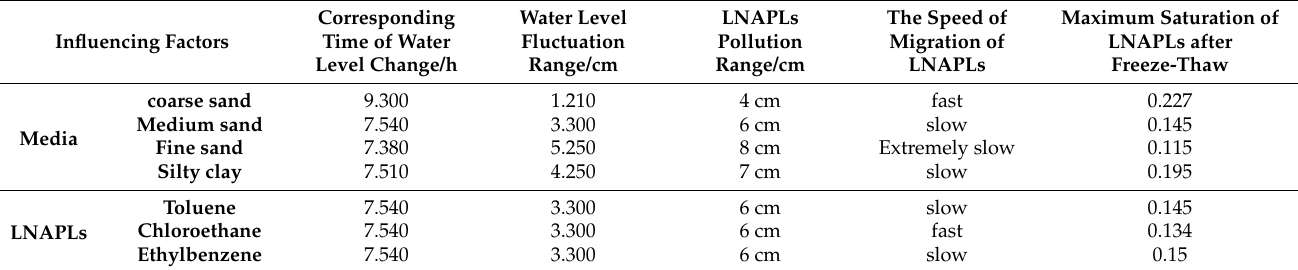
Table 3. Comparison of influencing factors.